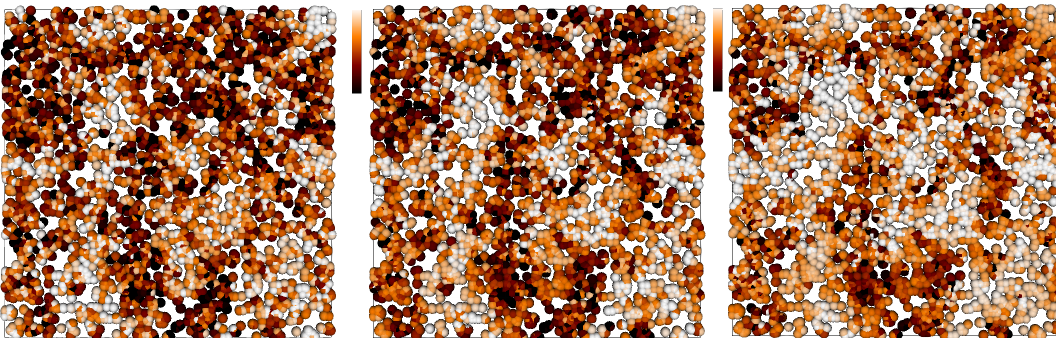
Figure 8. Visualizations of the Lagrangian vertical heat structure λ hsz in the same slice of the simulation volume shown in Figure 7, in simulation HC1 ( Pr = 0.1) for temperature separations ∆ T = 0.1 ( left ), ∆ T = 0.5 ( middle ), and ∆ T = 1.0 ( right ). Darker color indicates a lower value of λ